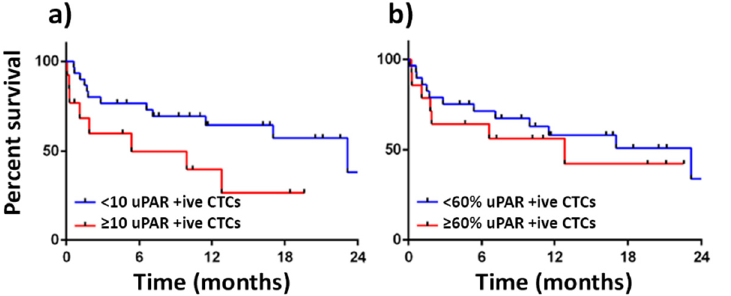
Figure 4. Kaplan Meier curves showing OS demonstrating (n = 43): ( a ) a trend of improved survival seen in patients with less than 10 EpCAM+/uPAR+ CTCs ( p = 0.06); ( b ) no survival benefit seen where more than 60% of EpCAM+ CTCs also co-expressed uPAR ( p = 0.5).